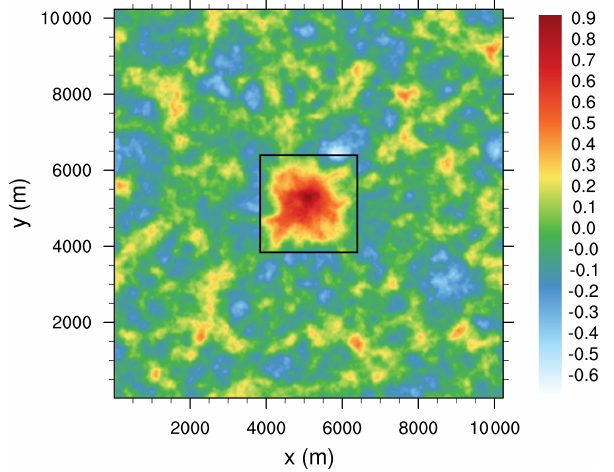
Figure 8. Horizontal cross section of 5h time-averaged vertical ve- locity at z = 400m in a nested simulation with a grid-spacing ratio of 2. The black box indicates the location of the child